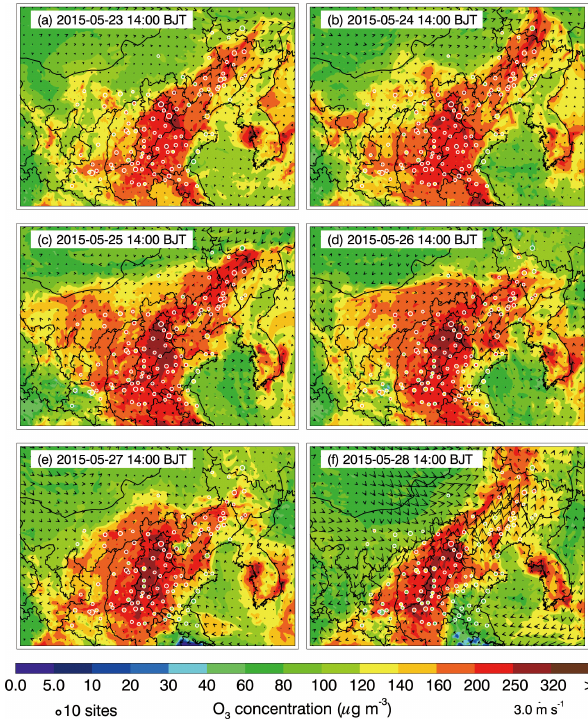
Figure 8. Same as Fig. 7, but for near-surface O 3 at